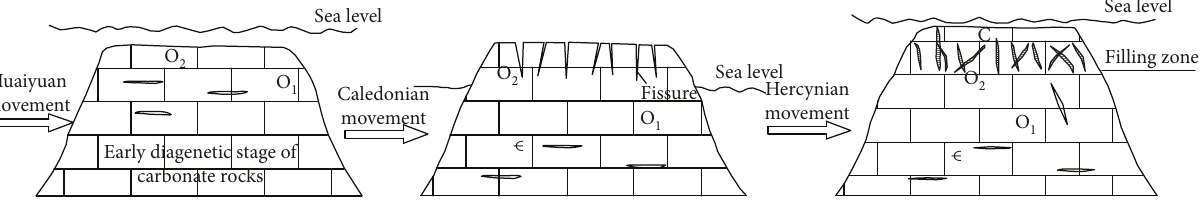
Figure 2: The developing stages of paleokarst in the North China Craton (modi fi ed from [28,